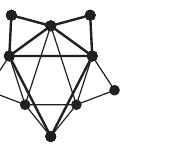
Fig. 2: On the left, an extended odd sun that is not minimal. Bold lines correspond to the edges of a proper induced extended odd sun, depicted on the